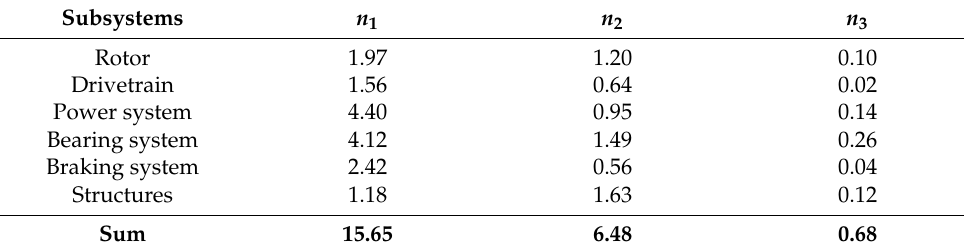
Table 3. The average number of subsystem failures and subsystem